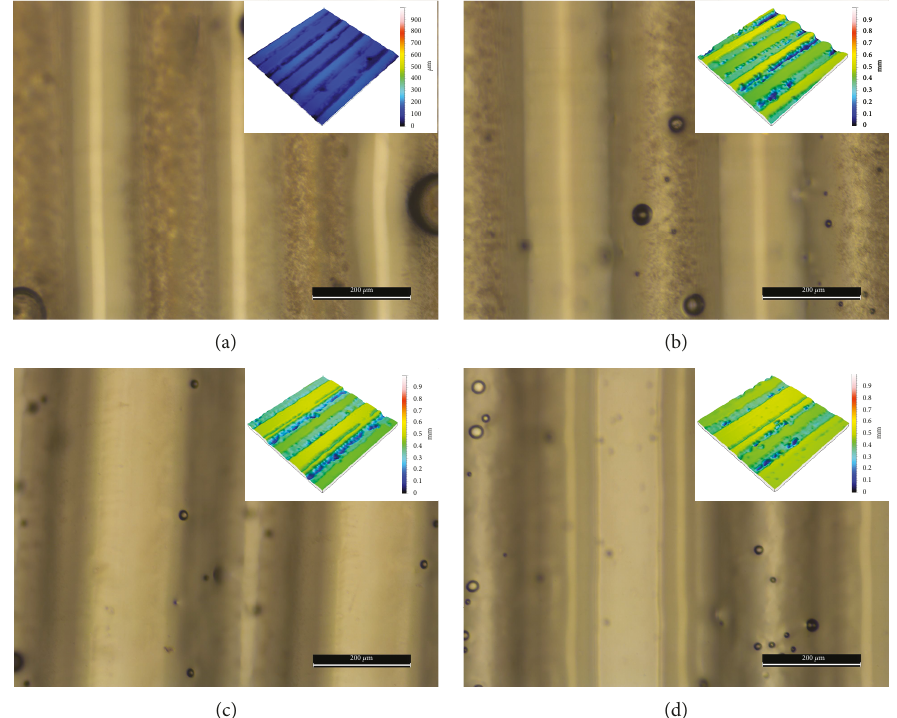
Figure 1: Optical micrographs of 4 laser-processed PET samples with increasing spacing between the parallel laser processing lines. (a) 300 μ m; (b) 400 μ m; (c) 500 μ m; (d) 600 μ m. All samples have been processed at 15% power and a scanning speed of 200 mm/s. The insets are CCI surface maps that have been set to the same z scale, and horizontally the scale bar is equal to 200 μ